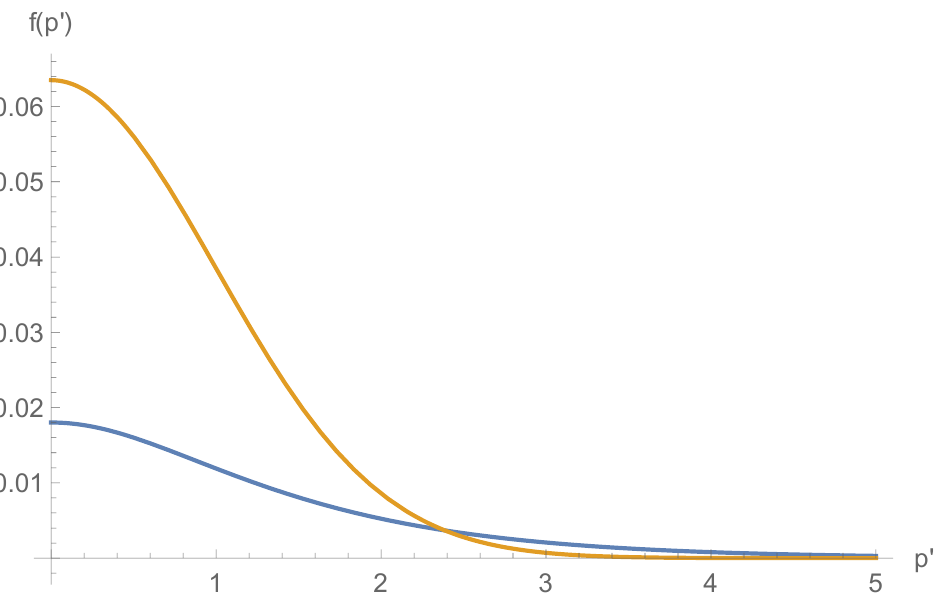
Figure 12. Probability density function for a free subluminal Lorentzian particle as function of p (cid:48) for λ = 1. The blue line depicts the correct value, while the orange line depicts the Maxwell– Boltzmann approximation.